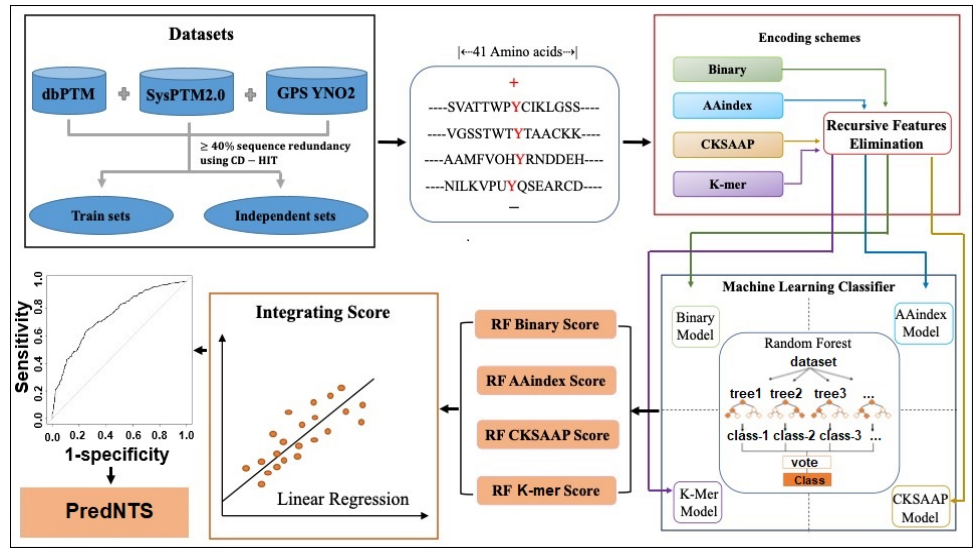
Figure 1. A framework for the PredNTS predictor and its server application. GPS, group-based prediction system; RF, random forest; RFE, recursive feature elimination; CKSAAP, composition of k-spaced amino acid pairs.